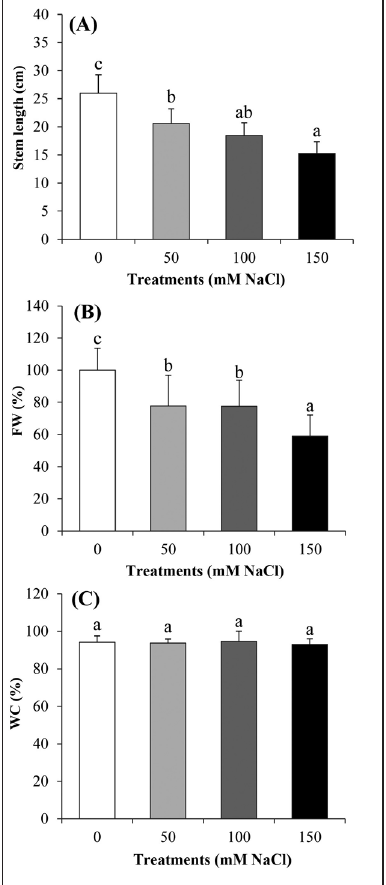
Fig. 1: Growth parameters in C. officinalis after four weeks of salt treat- ments. (A) Stem length (cm), (B) fresh weight of the aerial part (% of the control), and (C) water content percentage (WC %). Means with SD (n = 10). Different lowercase letters above the bars indicate significant differences between NaCl treatments, according to the Tukey test (α = 0.05).